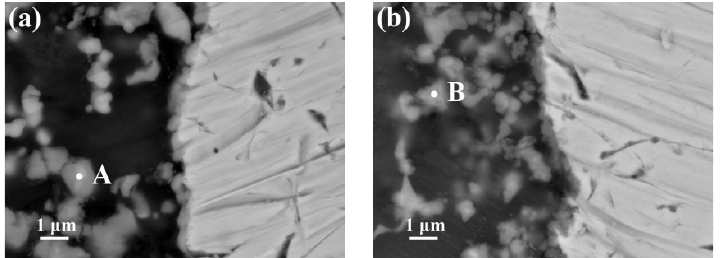
) for the major binary metal systems in this study. AB